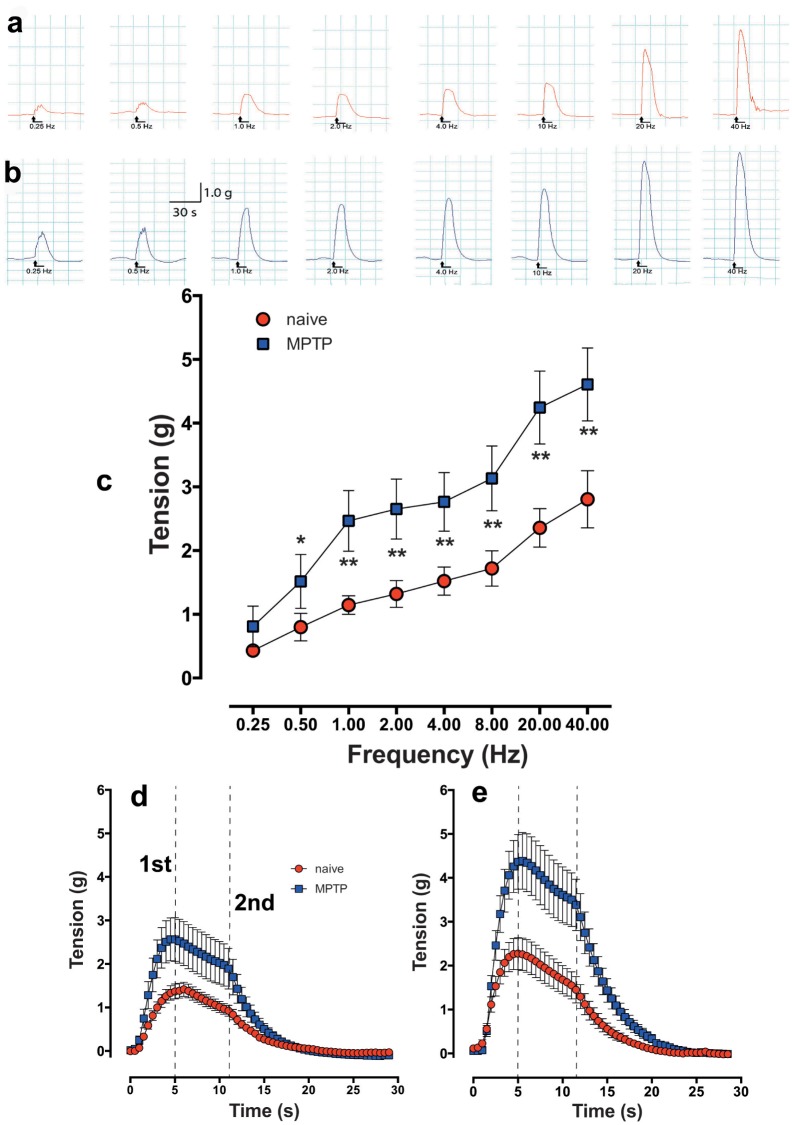
Frequency dependent increase in contractile response of isolated detrusor strips in response to EFS trains of 20 pulses at frequencies ranging from 0.25 to 40 Hz.Representative traces showing contractile responses of detrusor strips from drug-naïve (a) and MPTP-treated common marmoset (b) in response to trains of 20 pulses at frequencies ranging from 0.25 to 40 Hz. EFS-evoked contractile responses of MPTP-treated detrusor was larger at all stimulation frequencies above 1.0 Hz (c). Time course of EFS-evoked contractile responses of detrusor strips from normal and MPTP-treated common marmosets at 4 Hz (d) and 40 Hz (e) shows a biphasic contractile profile with two distinct 1st and 2nd peaks. The vertical lines marked 1st and 2nd indicate peak phasic and tonic responses respectively. Each data point represents mean ± sem (n = 19–22) * P<0.05, **P<0.005.